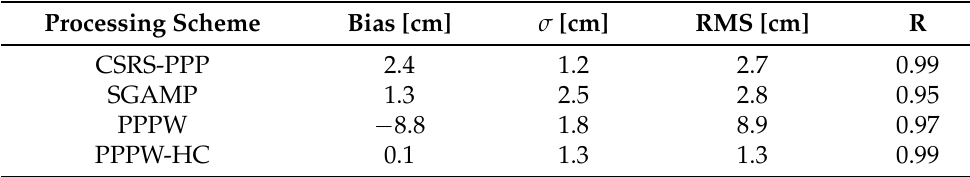
Table 5. The performance metrics for the ZTD validation against ERA-ZTD for the processing results of CSRS-PPP, SGAMP, PPPW, and PPPW-HC for